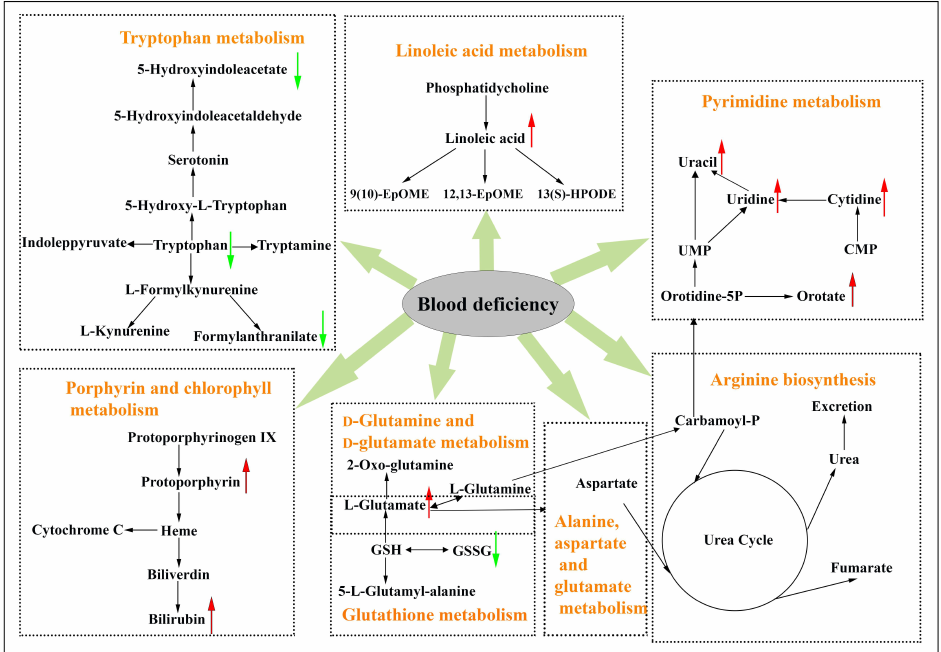
Figure 4. Correlation networks of main potential biomarkers related to blood deficiency and the effects of treatment for blood deficiency. The contents of potential biomarkers in model group compared to control group were marked with ( ↑ ) up-regulated and ( ↓ )